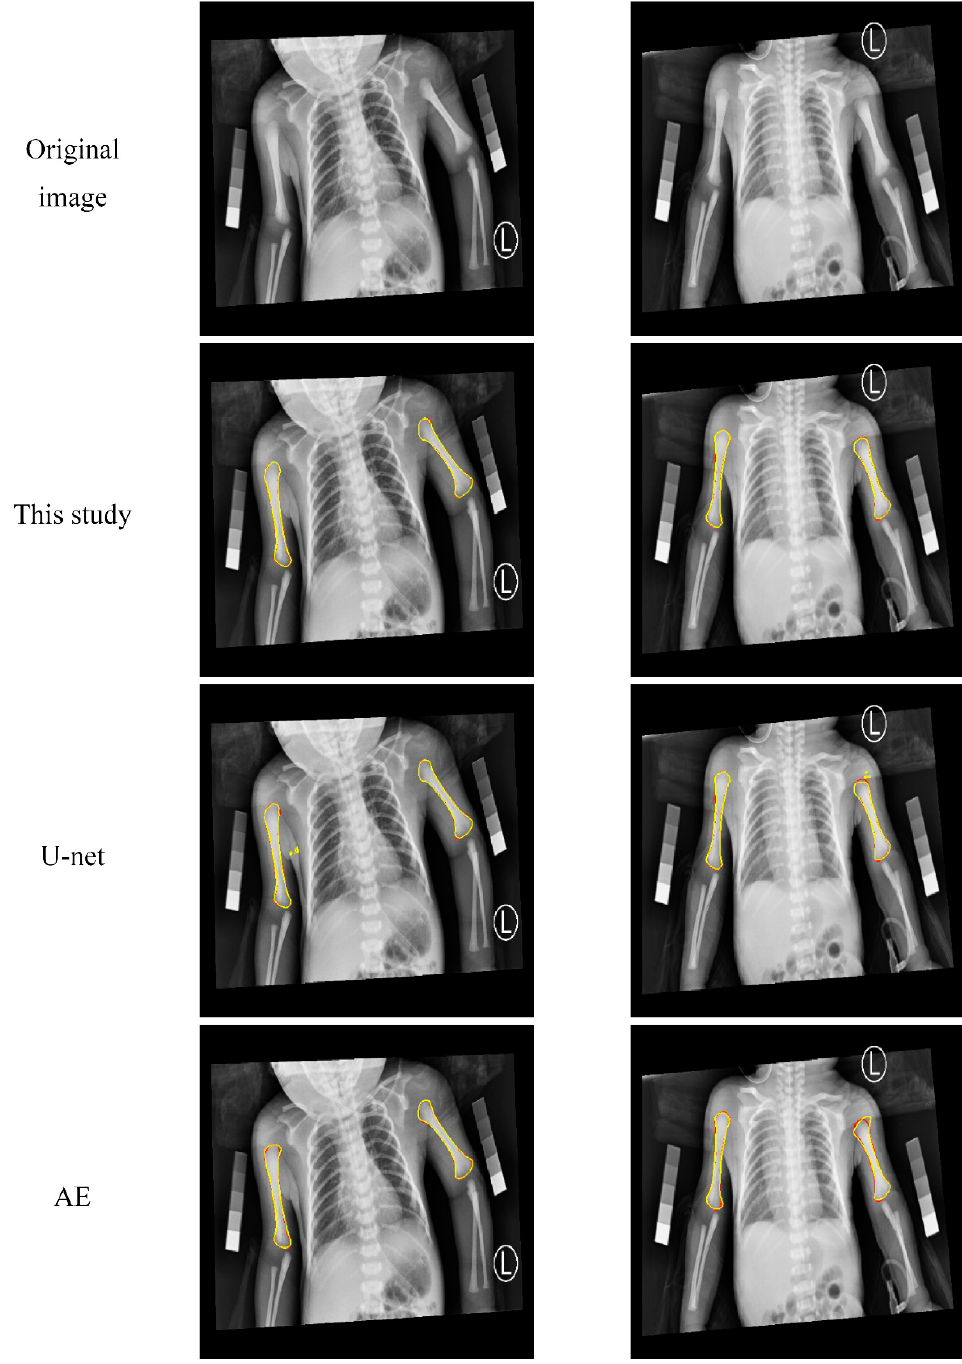
Figure 7. Visual comparison of the humerus segmentation results. The first row shows two examples of the original image. The second, third, and fourth rows represent the segmentation results of the proposed method, U-net, and auto-encoder (AE), respectively. The ground truth contours are in red, and segmented contours (in yellow) of the automatic method overlay on the ground truth contours.